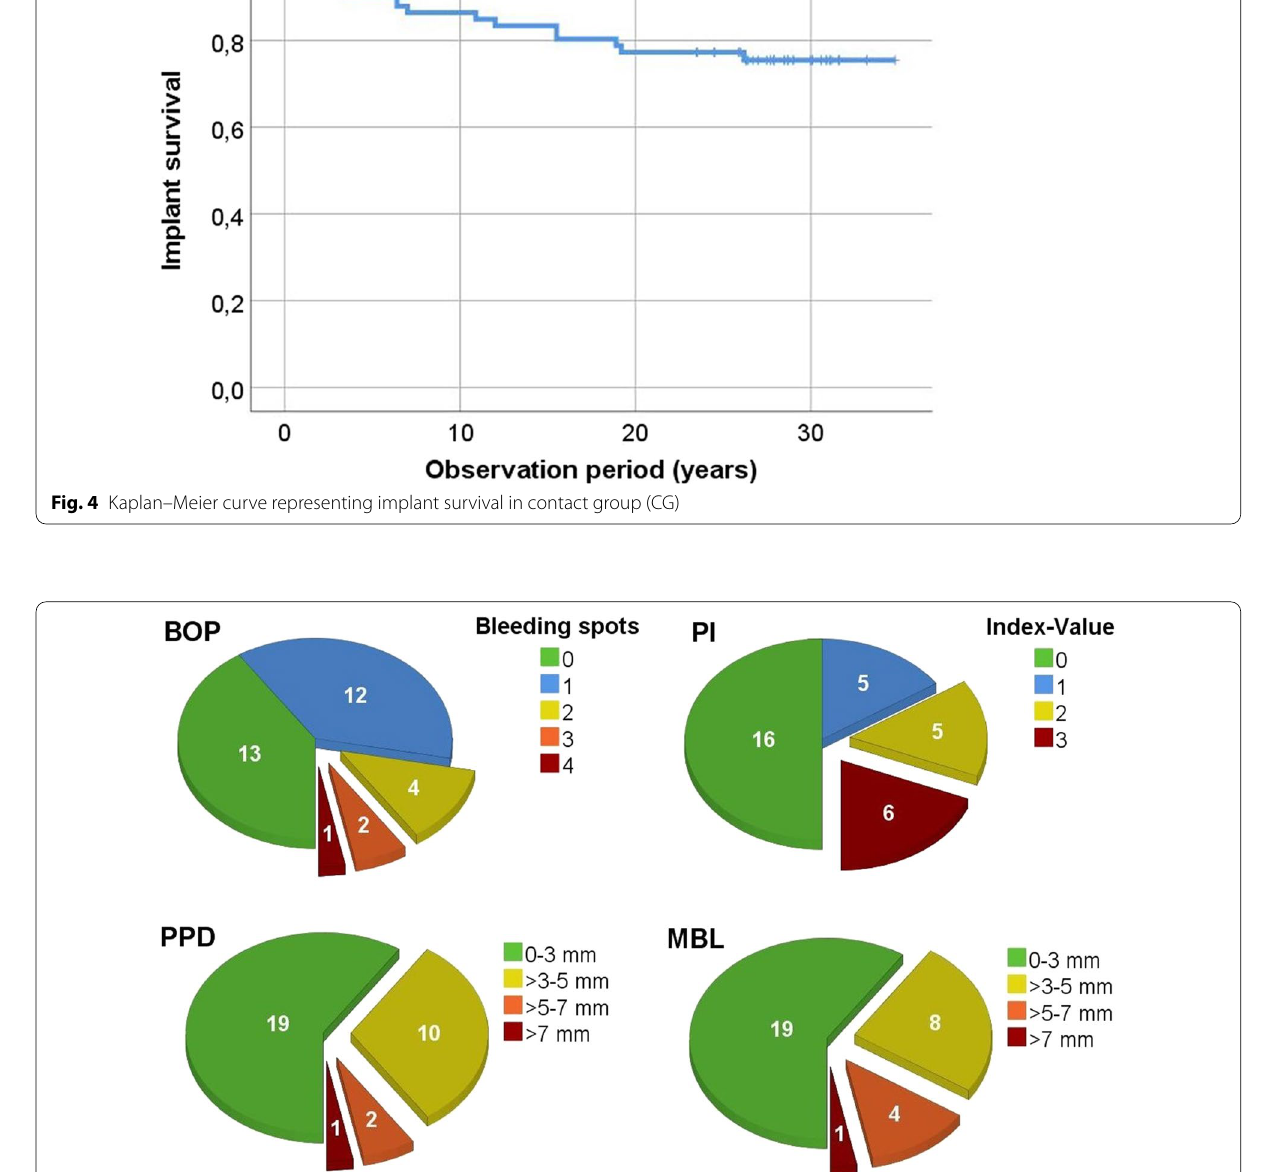
Fig. 5 Frequency distribution on severity level of implant characteristics grouped into four circle diagrams for each parameter: Plaque Index (PI); Bleeding on Probing (BOP); Pocket Probing Depth (PPD); and Marginal Bone Loss (MBL) after a mean observation time of 29 years in CEG (32 implants). Diagrams for PI, PPD and MBL show the highest measured value for each